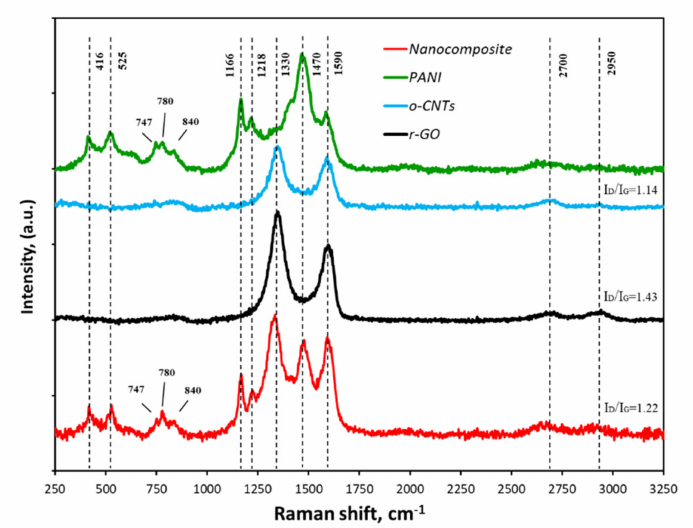
Figure 5. Raman-spectra of the initial materials and nanocomposite.